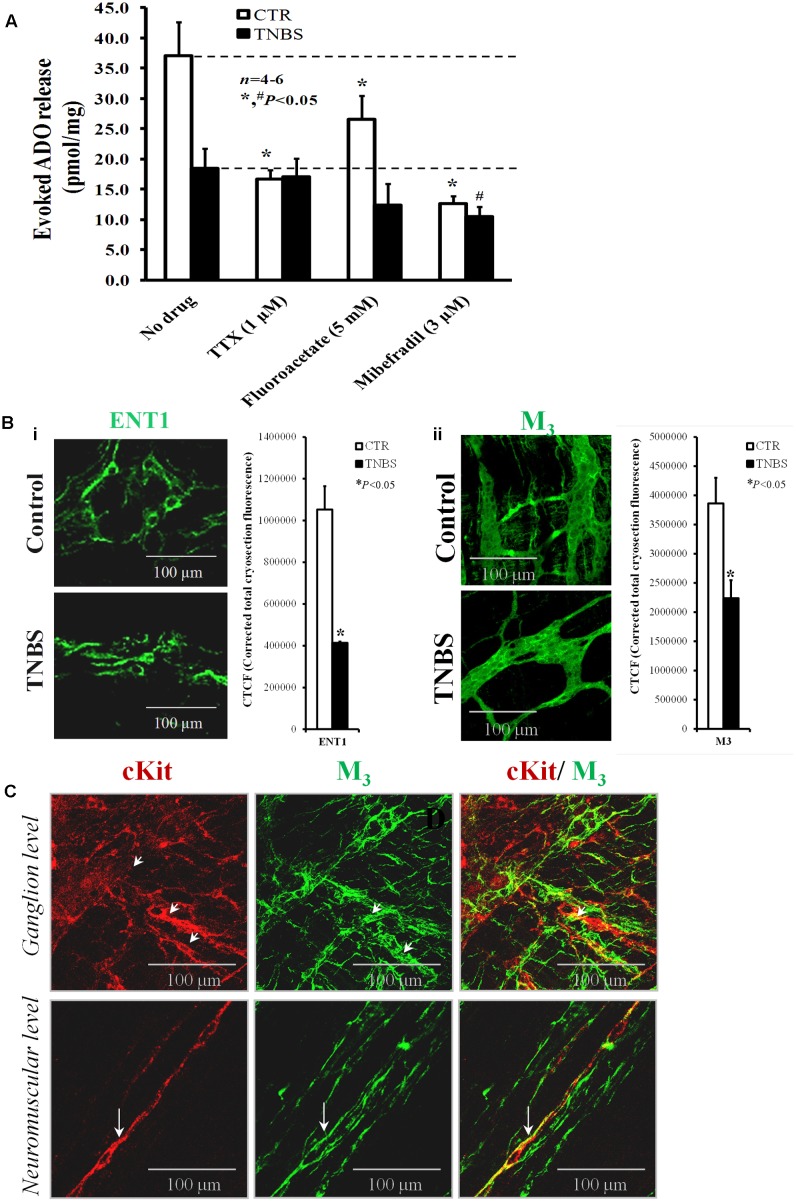
(A) Shows the effects of TTX (1 μM), sodium fluoroacetate (5 mM) and mibefradil (3 μM) on evoked adenosine (plus inosine) release from stimulated LM-MP ileal preparations of control and TNBS-treated rats. Drugs were in contact with the preparations for at least 15 min before EFS. Samples from the incubation media were collected and analyzed by HPLC with diode array detection to evaluate their content in adenine nucleosides (see Supplementary Figure S1); aliquots of the same samples were tested in parallel using the luciferin-luciferase bioluminescence assay for ATP quantification (results in Figure 7). Ordinates represent stimulation-induced increases in adenosine (plus inosine) above baseline levels determined immediately before EFS; results are expressed in pmol/mg of tissue. The data are means ± SEM of four to six individuals. ∗,#P < 0.05 (unpaired Student’s t-test with Welch correction) represent significant differences from the amount of adenosine (plus inosine) released in the absence of any drug added to preparations from control and TNBS-treated animals (dashed horizontal lines), respectively. (B) Shown are confocal micrographs of whole-mount preparations of the longitudinal muscle-myenteric plexus of the ileum from control and TNBS-treated rats stained against the equilibrative nucleoside transporter 1 (ENT1) (i) and the muscarinic M3 receptor. The staining pattern of both antibodies resembles that obtained for anoctamine-1 (Ano-1)-positive interstitial cells at the ganglion level shown Figure 2. Images are representative of at least four individuals per group. Scale bar = 100 μM. Bar charts at the right hand-side panels represents mean ± SEM of corrected total cryosection fluorescence (CTCF) of ENT-1 and muscarinic M3 antibodies staining, respectively. ∗P < 0.05 (unpaired Student’s t-test with Welch correction) represent significant differences from control animals. (C) Shown is confocal micrographs of whole-mount preparations of the longitudinal muscle-myenteric plexus (LM-MP) of the ileum of control rats. Please note that the majority of c-Kit positive interstitial cells of Cajal (ICCs, red) at the neuromuscular region are endowed with muscarinic M3 receptors (green) (long arrows); although co-localization of c-kit (red) and muscarinic M3 receptor (green) is still apparent at the myenteric ganglion level (small arrows), most of the cells express only one of these markers. Yellow staining denotes co-localization when overlaying the green and red confocal channels.